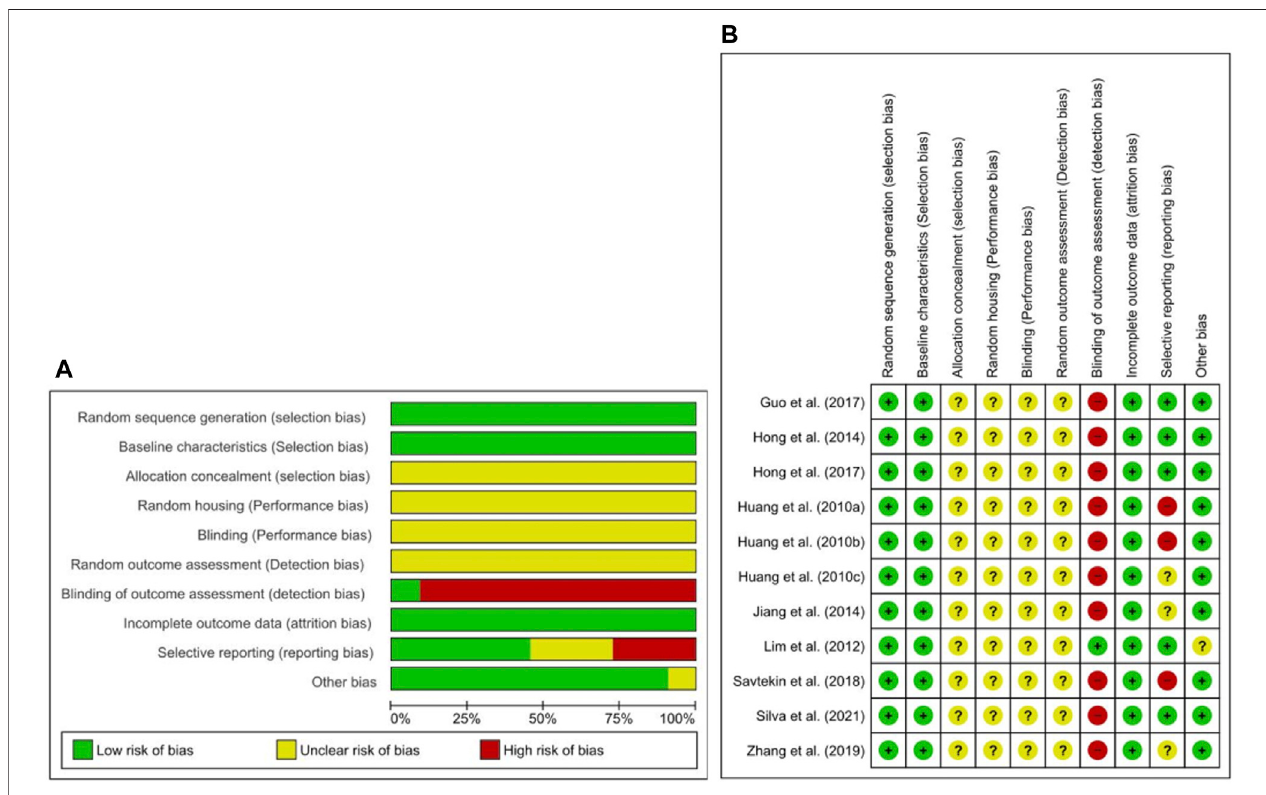
FIGURE 2 | Risk of bias. (A) Overall risk of bias for each item in the SYRCLE tool for all included studies. Each risk of bias item is presented as a percentage based on all included studies. (B) Individual risk of bias for each of the included animal studies. Each item in the SYRCLE tool was scored as “ yes ” , “ no ” , or “ unclear ” .